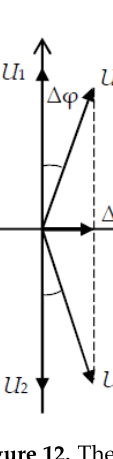
Figure 11. The experimental setup with test model of the RRS SE on CPAW.